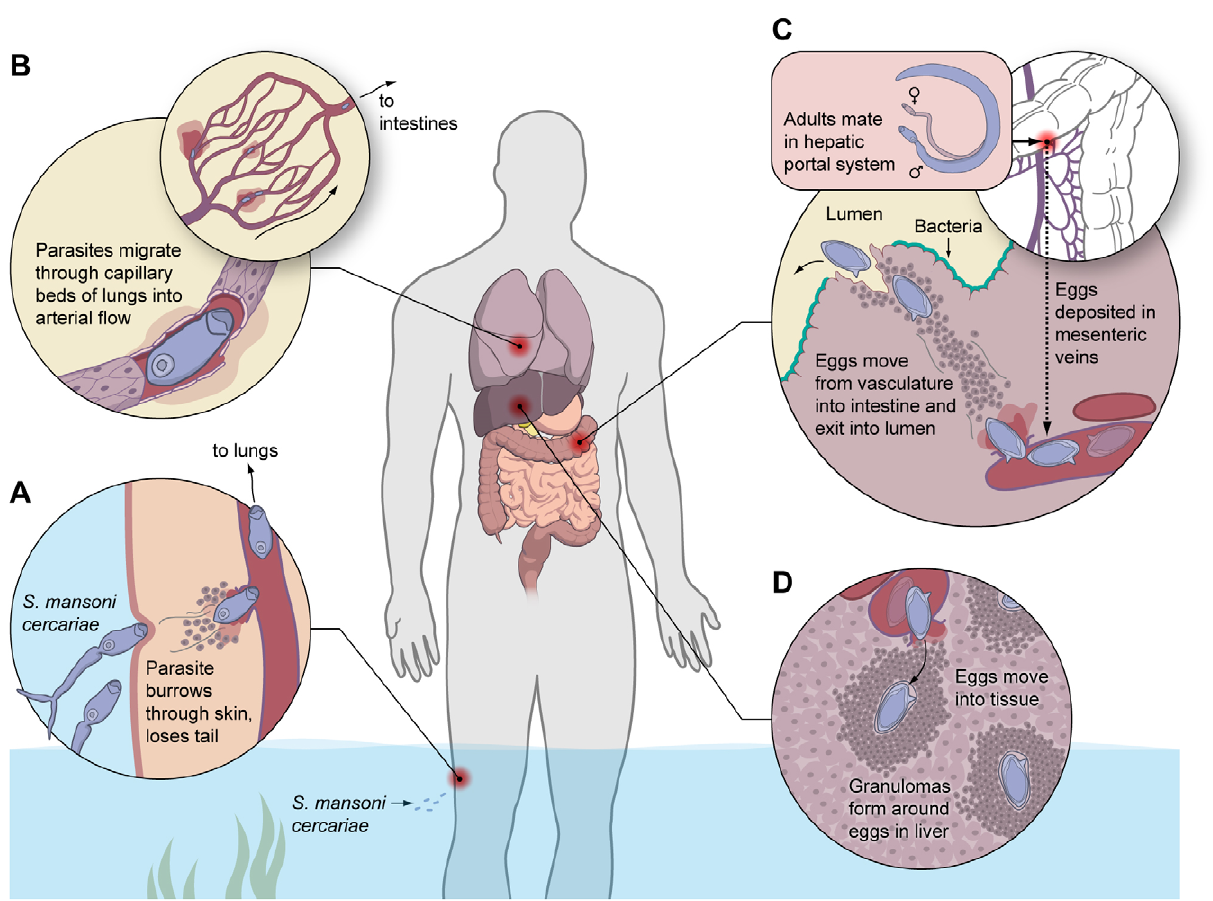
Figure 1. Helminths induce extensive tissue damage, providing evolutionary pressure for an adaptive Th2-mediated wound healing response. In this example, a human infected with the helminth parasite S. mansoni is faced with constant tissue damage as the parasite completes its life cycle. (A) Infectious cercariae are released from the intermediate snail host and are attracted to lipids found on human skin. Once attached to the skin, they often enter through hair follicles where they secrete proteases, degrade basement membranes, and ultimately gain access to the vasculature. (B) Immature schistosomula are then swept up in the heart and lodge in the lungs, where they must cross capillary beds to enter the arterial flow. (C) Eventually, adult parasites find their way to the mesenteric veins, where they mate and begin laying eggs. Many of the eggs migrate from the vasculature, enter the wall of the intestine and literally burrow through until they reach the lumen and are excreted in the feces. (D) A subset of eggs is swept by the blood flow into the liver where they are trapped in the small sinusoidal vessels, inducing a vigorous granulomatous response. Thus, at nearly all stages of the parasite’s life cycle, it is inducing significant tissue damage and hemorrhaging in the definitive host. It is imperative that ‘‘holes’’ in important barriers are repaired quickly; otherwise, bacteria would quickly invade and take